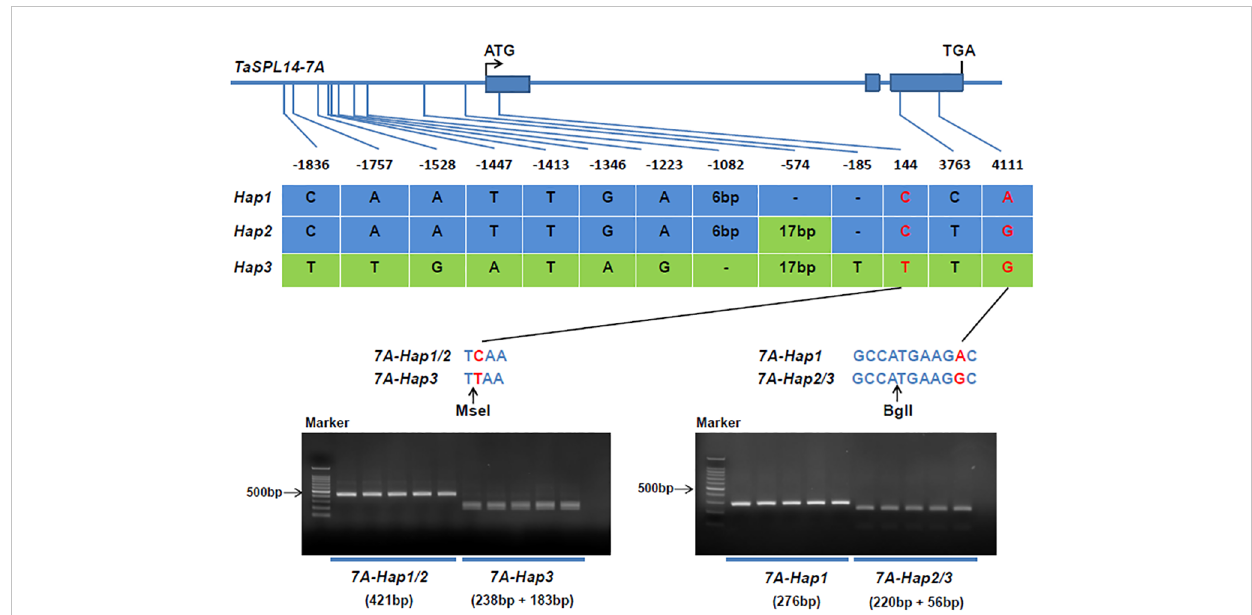
FIGURE 4 Identi fi cation of TaSPL14-7A haplotypes and development of molecular markers. The top panel shows a schematic diagram of the gene and 2.5 kb promoter structure of TaSPL14-7A . The ATG start codon was designated as position 1 bp. The bottom panel shows the polymorphic sites of TaSPL14-7A . A CAPS marker named CAPS-144 was developed based on the SNP (T/C) at 144 bp. Digestion of the ampli fi ed 421 bp fragment with MseI produced fragments of 238 bp and 183 bp for TaSPL14-7A-Hap3 (T), whereas this fragment could not be digested for TaSPL14-7A-Hap1/2 (C). A CAPS marker named CAPS-4111 was developed based on the SNP (G/A) at 4111 bp. Digestion of the ampli fi ed 276 bp fragment with BglI produced fragments of 220 bp and 56 bp for TaSPL14-7A-Hap2/3 (G), whereas this fragment could not be digested for TaSPL14-7A-Hap1